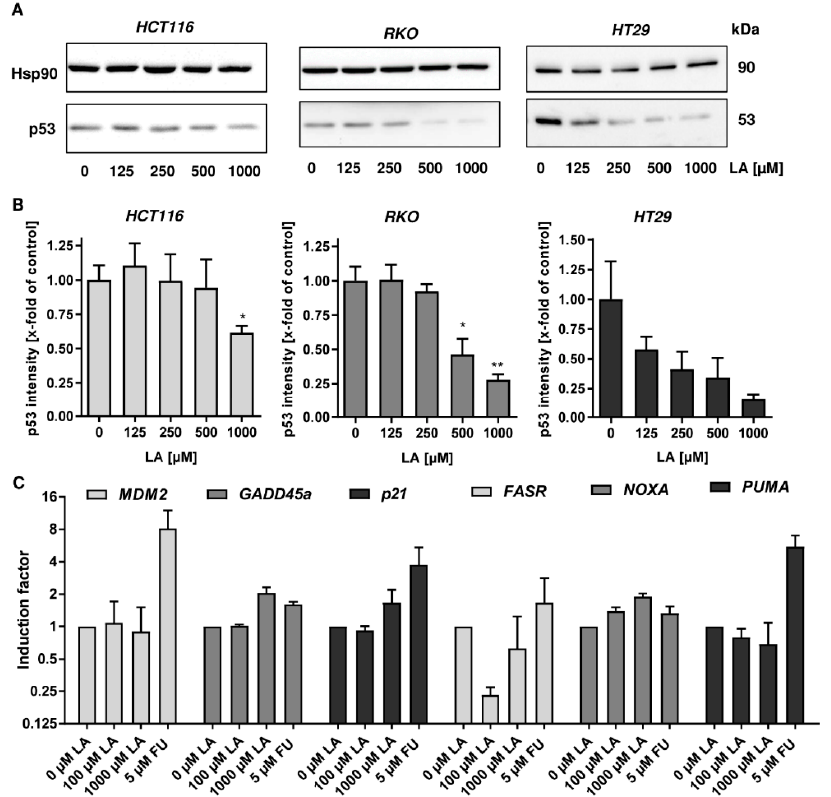
Figure 2. Early p53 depletion in CRC cells and impact on p53-dependent gene expression. ( A ) CRC cells with wildtype p53 (HCT116 and RKO) and mutant p53 (HT29) were treated with increasing doses of LA for 24 h as indicated. EtOH was included as solvent control (0 µM). Depletion of p53 was monitored using western blot analysis. Hsp90 was visualized as loading control. ( B ) Densitometric analysis of data presented in A. p53 levels were normalized to Hsp90. Data is presented as mean + SEM ( n = 3). * p < 0.05; ** p < 0.01. ( C ) Gene expression of p53 targets genes ( MDM2 , GADD45a , p21 , FASR , NOXA , and PUMA ) in HCT116 cells treated with LA for 24 h determined by qPCR analysis. EtOH served as solvent control (0 µM LA), while 5-FU was used as positive control. Gene expression levels are normalized to ACTB and GAPDH . Data is presented as mean + SEM ( n = 3), except for FASR analysis ( n = 2).